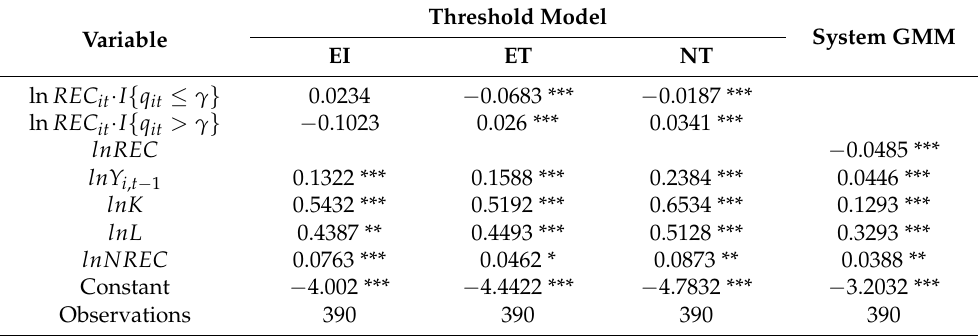
Table 6. Regression estimation